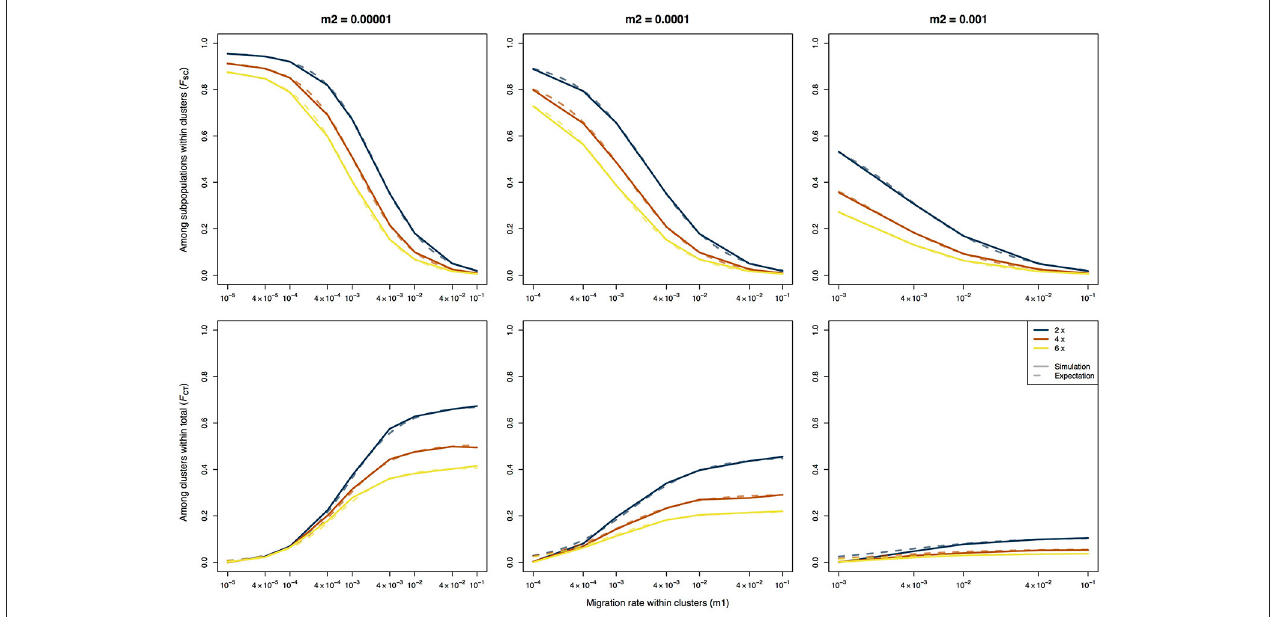
FIGURE 1 | F -statistics calculated using an AMOVA on data of three different ploidy levels simulated using a hierarchical island model of migration. The solid lines represent the results of the simulations, the dashed lines represent the expected values based on the derivations of Vigouroux and Couvet